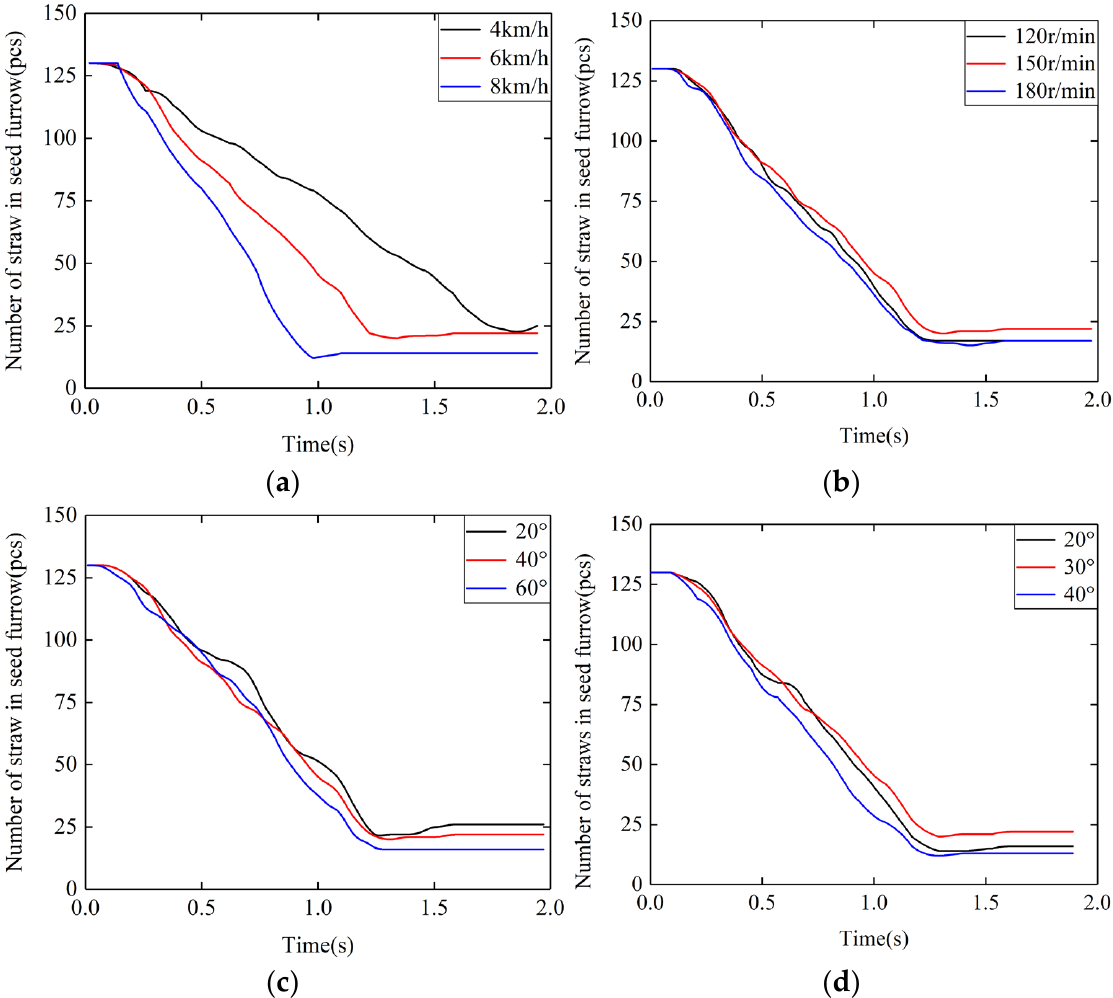
Figure 15. Variation curve of straw quantity in seed furrow clearing under different parameters. ( a ) Forwarding speed; ( b ) Rotating speed; ( c ) Installation inclination angle of spring teeth; ( d ) Bending angle of spring teeth. Soil disturbance affects the original shape of the seed furrow. Hence, in order to maintain the shape of the seed furrow, it is required that the spring teeth have little disturbance to the soil in the seed furrow. The variation curve of soil disturbance in seed furrow clearing under different parameters is shown in Figure 16. It can be seen from Figure 16a that the soil disturbance increases with the decrease of forwarding speed. When v j = 4 km/h, the soil disturbance is the largest, and when v j = 6 km/h and v j = 8 km/h, the soil disturbance is not much different during 0.5~2.0 s. Figure 16b, c shows the variation curve of soil disturbance under different rotating speeds and installation inclination angles, respectively. With the increase of the rotating speeds and installation inclination angle, the soil disturbance increases. Figure 16d shows the variation curve of soil disturbance under different bending angles. When the bending angle α = 20 ◦ and α = 30 ◦ , the variation trend of soil disturbance in the whole operation process is basically the same. When the bending angle α = 40 ◦ , the soil disturbance is greater than that of the bending angle α = 20 ◦ and α = 30 ◦ during 0.5~1.0 s, and the variation trend is basically the same in other time periods. Therefore, the change of bending angle has little effect on soil